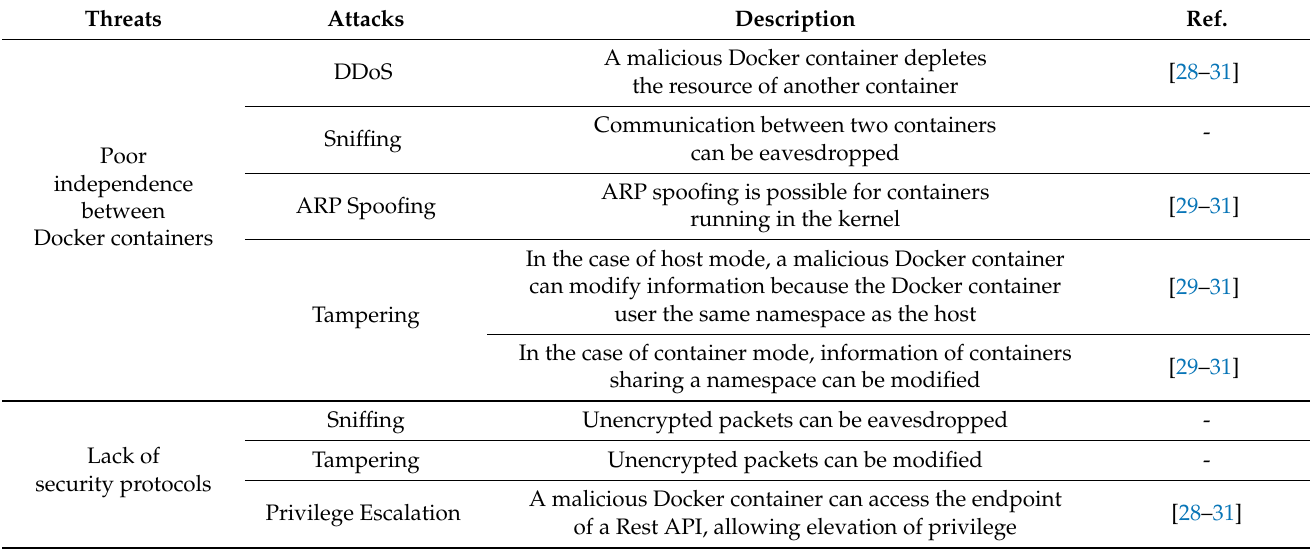
Table 4. Network security threats and related attacks for an inter Docker